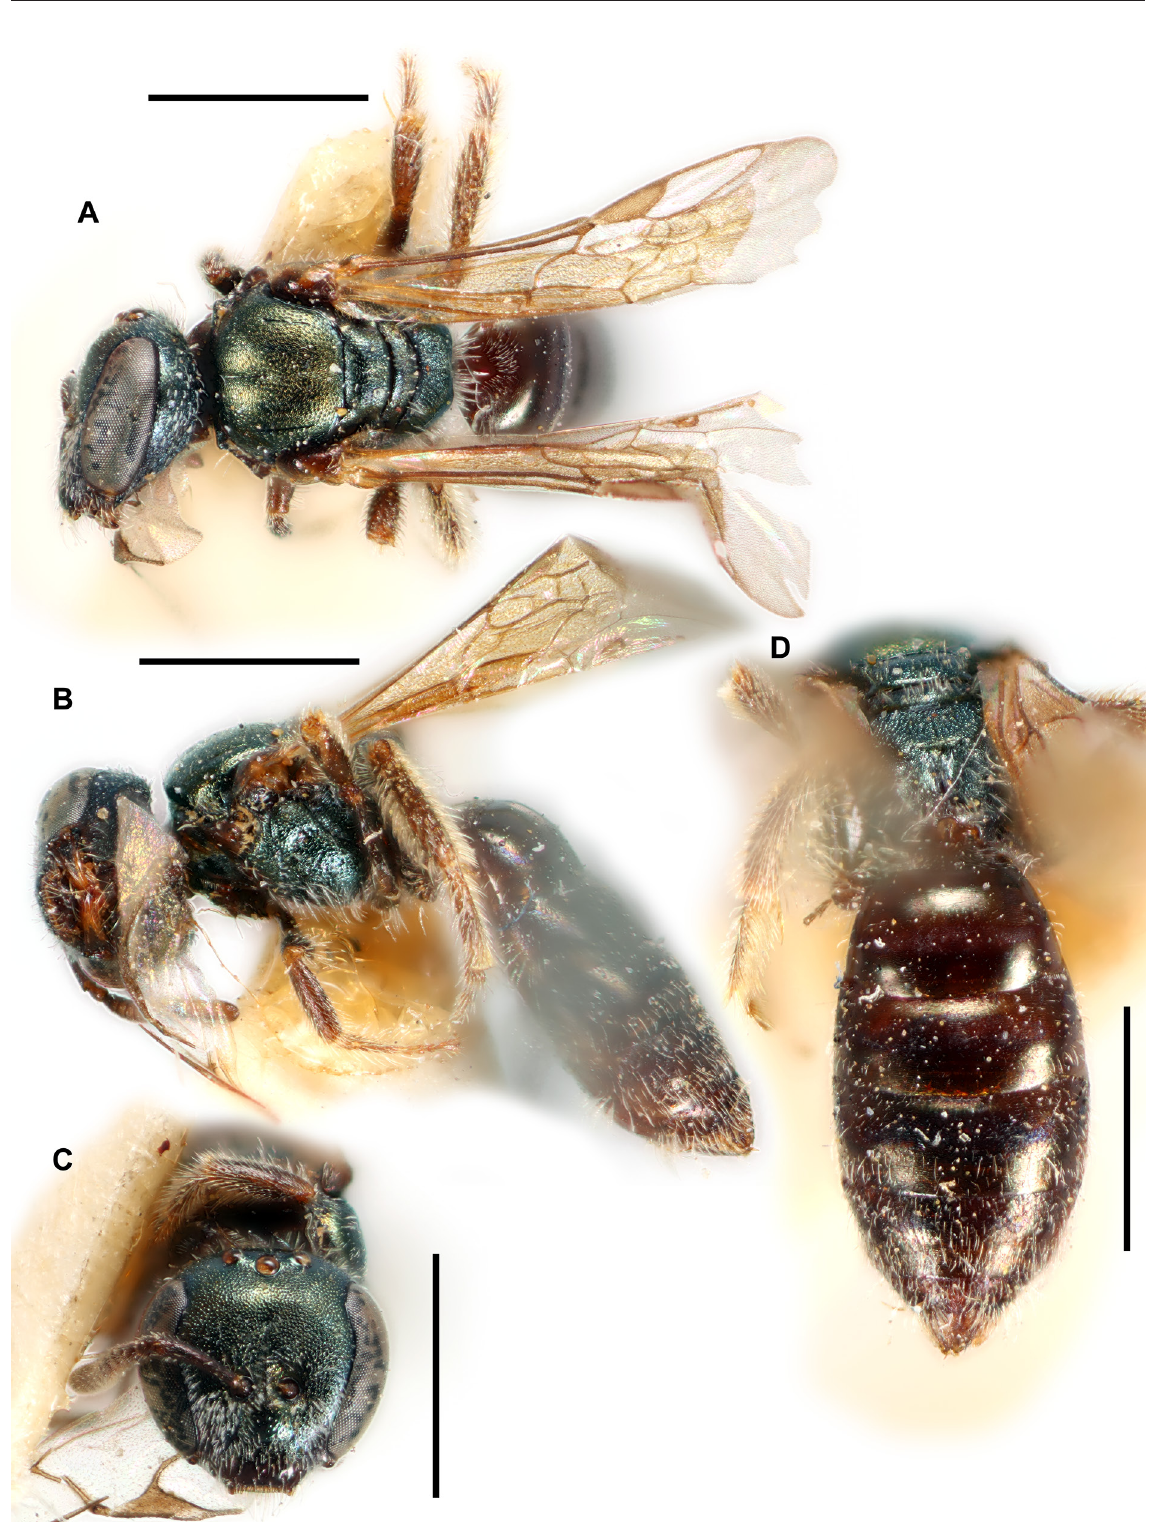
Fig. 45. Lasioglossum ( D .) perparvum (Ellis, 1914), ♀, holotype (USNM). A . Dorsal habitus. B . Lateral habitus. C . Face. D . Metasoma and propodeum. Scale bars = 1